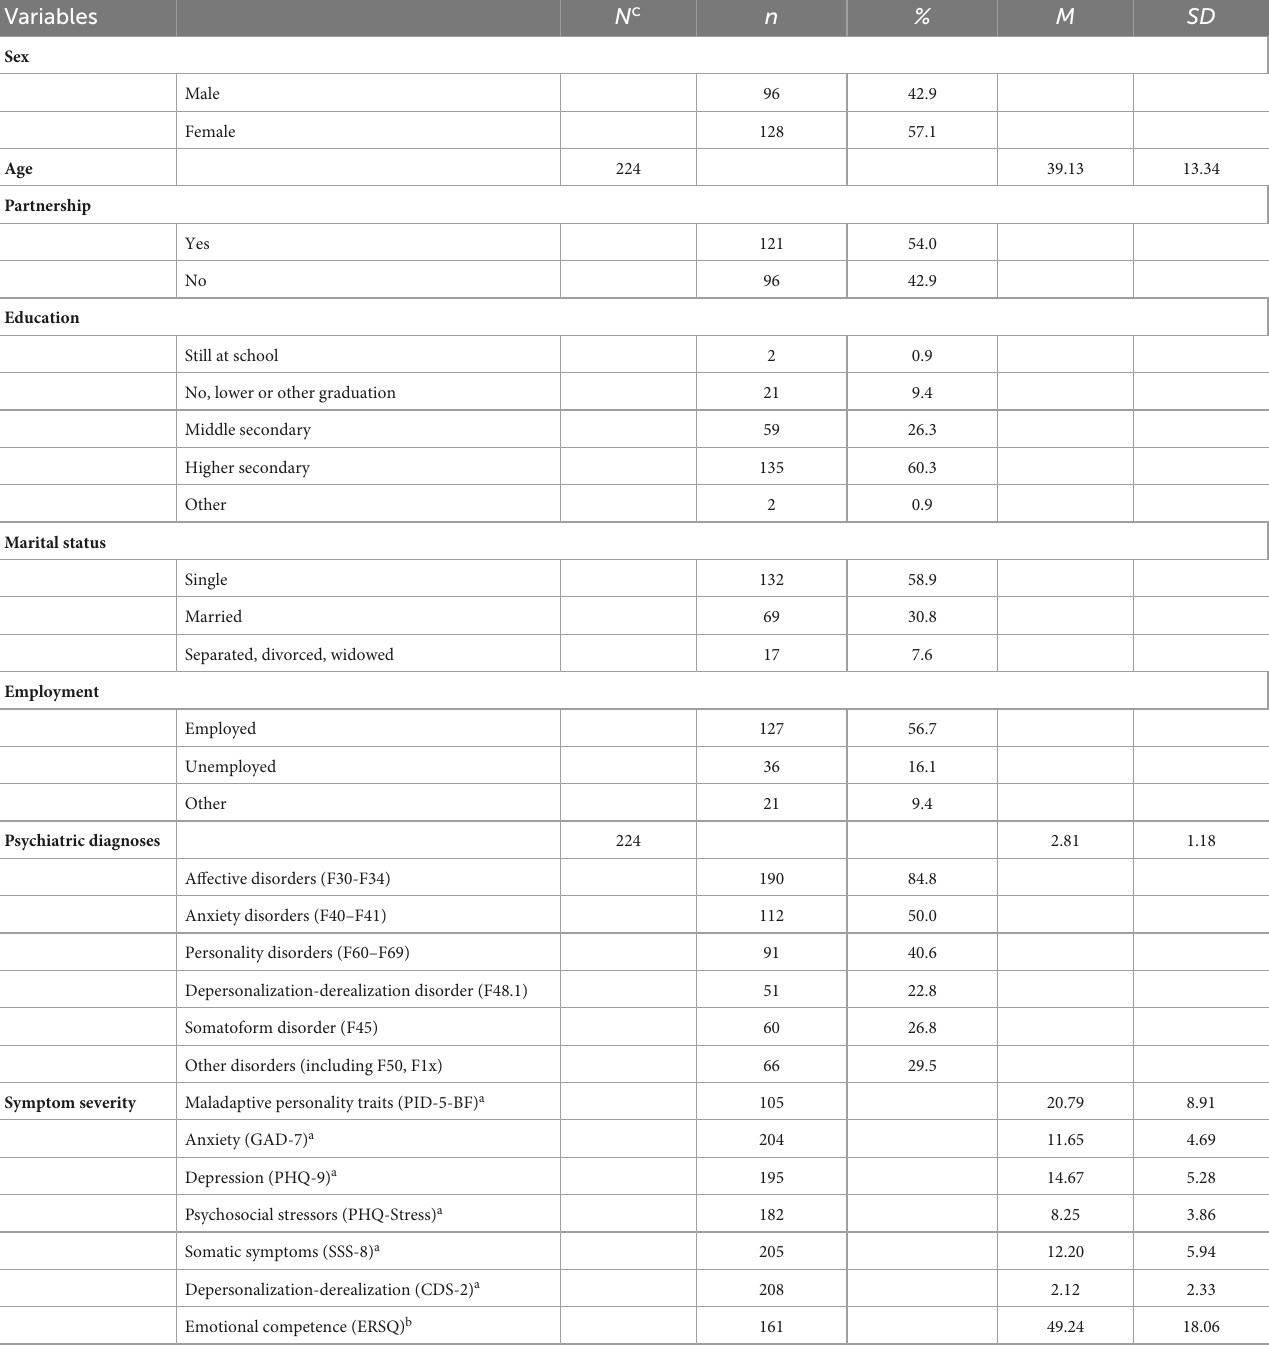
TABLE 1 Sociodemographic and medical data of the sample.